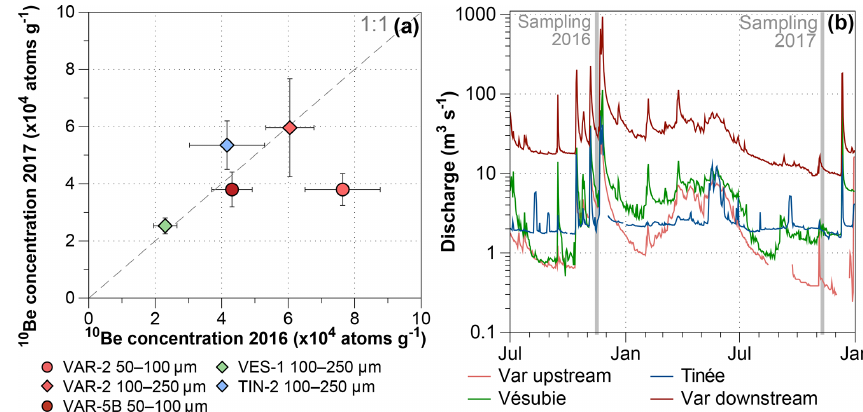
Figure 7. Interannual variability of sediment 10 Be concentrations. (a) Concentrations in sediments sampled in 2016 ( x axis) are plotted against sediments of the same size fraction sampled in the same locations in 2017 ( y axis). Most samples are in agreement with the 1 : 1 line, indicating little interannual variation. Only the 50–100µm fraction at VAR-2 does not show the same trend. (b) Daily discharge data (log scale) from four hydrological stations in the Var basin (see Fig. 1): Var upstream (station I, Villneuve d’Entraunes), Vésubie (station IV, Utelle), Tinée (station III, Saint-Sauveur-sur-Tinée), and Var downstream (station II, Nice, Pont Napoléon). Discharge data are freely accessible at http://www.hydro.eaufrance.fr/ (last access: 6 December